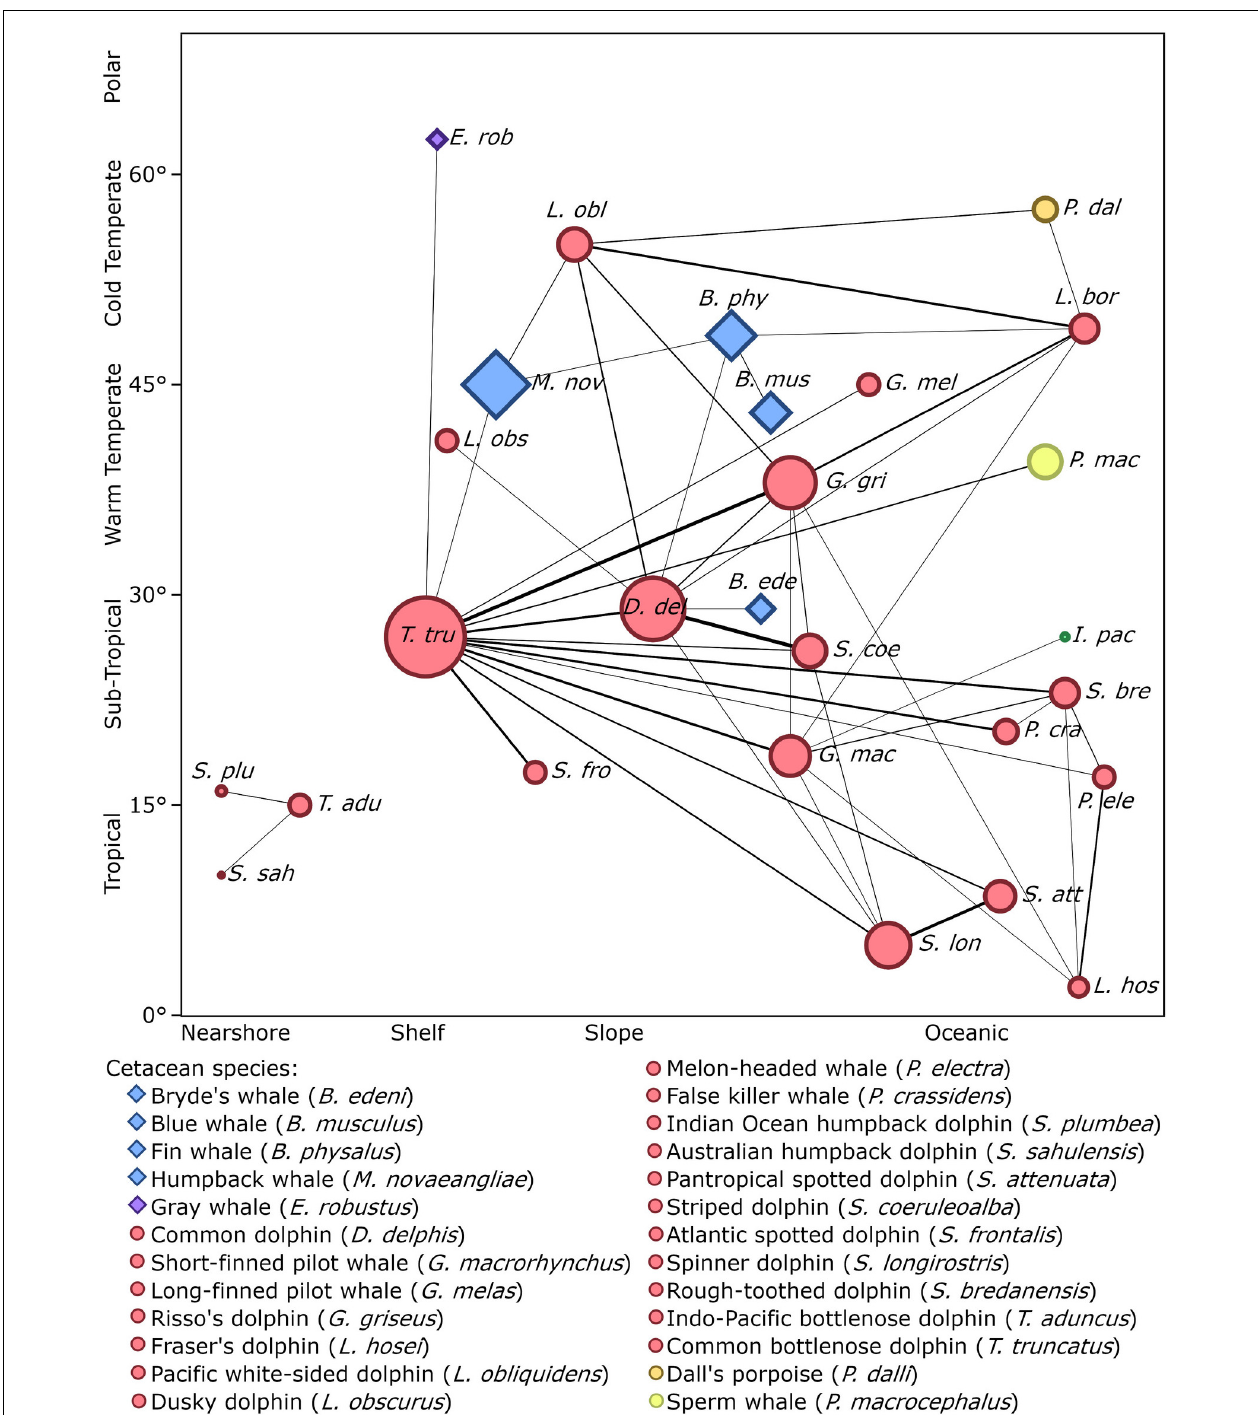
FIGURE 4 | Social network diagram showing the 47 species pairs (edges) that were reported together in mixed-species groups by five or more of the studies reviewed. The width of each edge is proportional to the total number of studies that reported that pair of species. The shape of each node indicates if the species is a Mysticete (diamond) or an Odontocete (circle) while the colours represent the species’ family. The size of each node is proportional to the total number of partner species that each species has. Each species’ node is placed approximately according to its average distribution with the x axis representing water depth and the y axis representing latitude. An interactive version of this network containing all 216 species pairs is available in Supplementary Figure 1 .